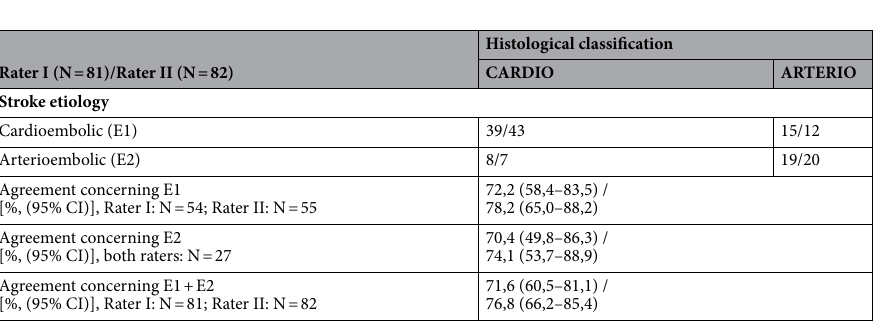
Table 2. Fourfold table of the validation data. Stroke etiology was independently determined by three stroke experts based on complete anamnestic information and diagnostic results concerning cause analysis of stroke. Histological classification was performed by two independent raters that were blinded for the defined etiology of the thrombotic emboli. Values for both raters are indicated before (rater I) and after (rater II) the slash. CI = confidence